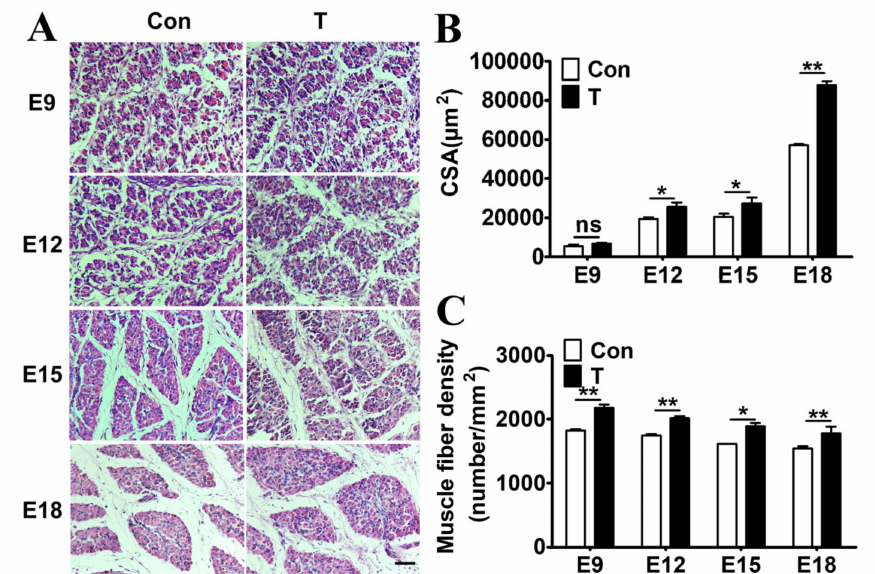
Figure 2. E ff ect of T treatment on myofiber properties. ( A ): HE staining of para ffi n sections of leg muscles at E9–E18. The cross-sectional area of myofibers ( B ) and myofiber density ( C ) was measured. Scale bar: 100 µ m. Data are presented as the means + SE. Asterisk (*) represents statistically di ff erent ( p < 0.05). p < 0.01 is shown as **.